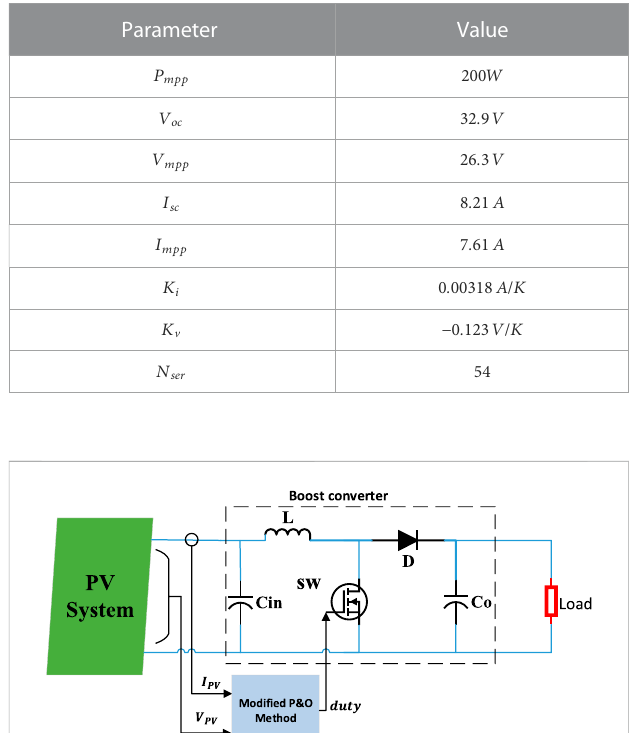
FIGURE 2 Block diagram of the suggested MPPT controller with boots